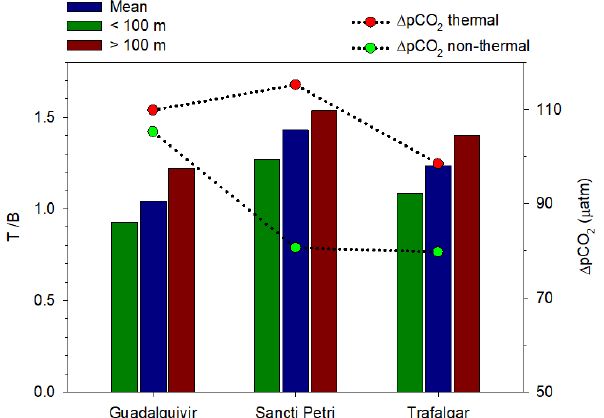
Figure 9. Variation of the T/B ratio (blue bar), the T/B ratio at depths <100m (green bar), the T/B ratio at depths>100m (red bar), and (cid:49)p CO 2 non-thermal effects (green point) and (cid:49)p CO 2 thermal effects (red point) on the three transects of the study (Guadalquivir, Sancti Petri and Trafalgar) during the eight cruises.